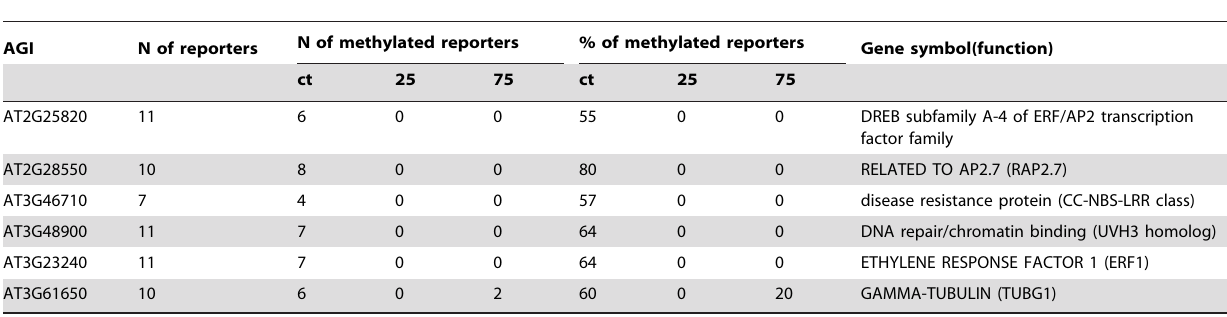
Table 2. Promoters hypomethylated in the progeny of stressed plants.